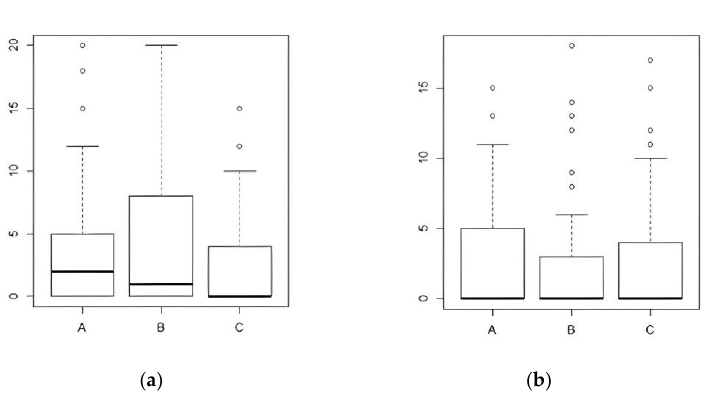
Figure 5. Comparison between preoperative ( a ) and postoperative EAT data ( b ) based on monitoring techniques. A = visual technique; B = intermittent nerve monitoring; C = continuous nerve monitoring.